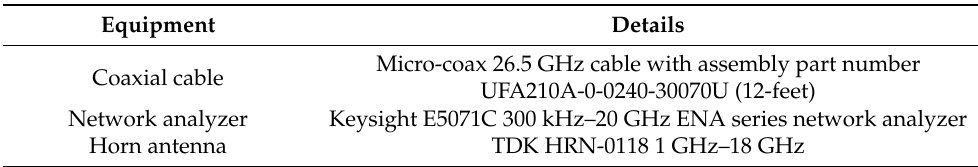
Figure 9. ( a ) The 3D-printed microstrip patch antenna prototype set on the positioner in an anechoic chamber. The antenna prototype is mounted on a cylindrical curved surface; ( b ) the gain and radiation pattern measurement set-up of the 3D-printed Electrifi patch prototype in an anechoic chamber. Table 2. Details of the equipment used for the experimental